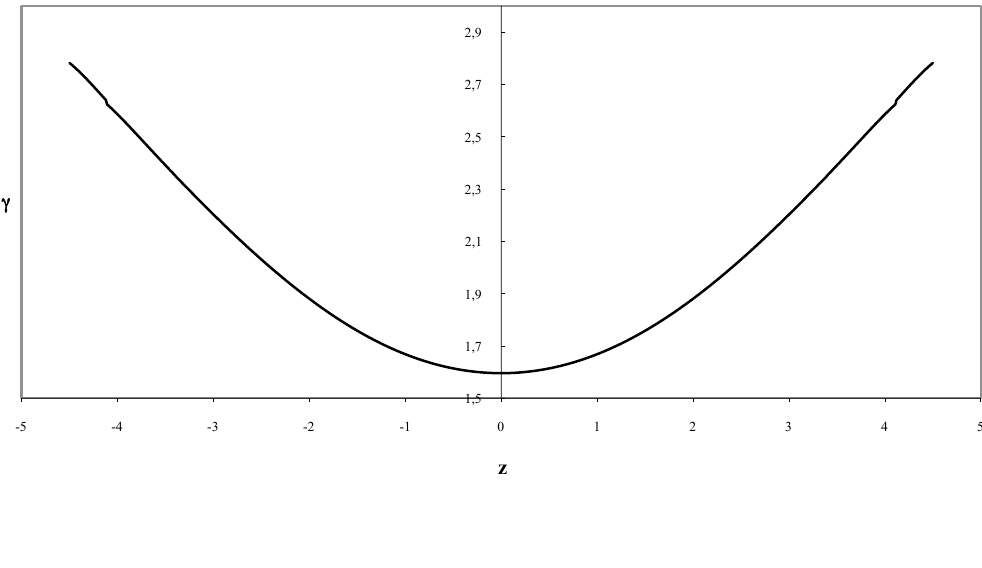
Figure 3. “The variation of γ as a function of